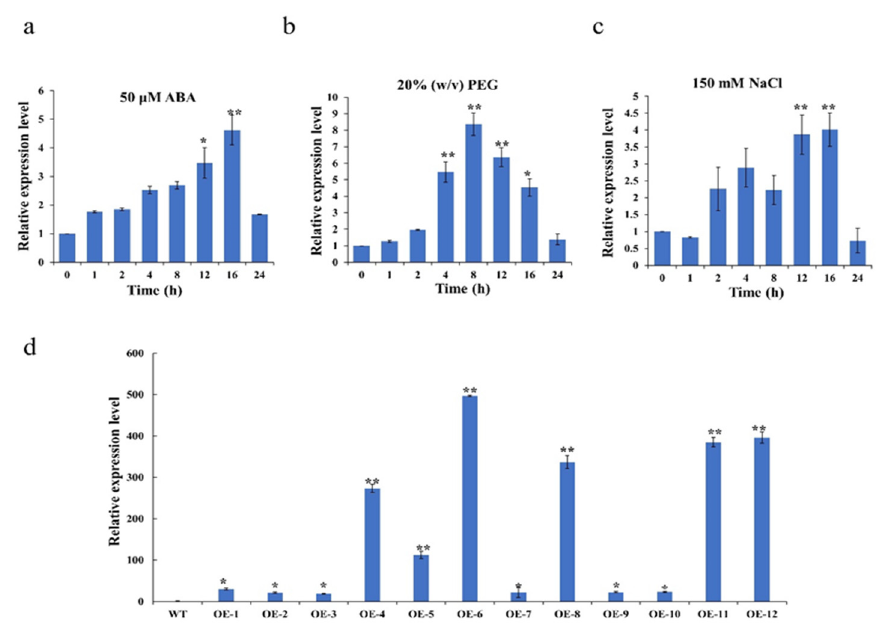
Figure 3. Expression analysis of OsMLP423 under different stresses and strains selection. ( a – c ) RT- analysis of OsMLP423 : ( a ) 50 µ M ABA; ( b ) 20% w / v PEG; ( c ) 150 mM NaCl. ( d ) Expression levels of PCR analysis of OsMLP423 : ( a ) 50 μ M ABA; ( b ) 20% w / v PEG; ( c ) 150 mM NaCl). ( d ) Expression OsMLP423 transgenic lines. Values are mean ± SE ( n = 3). Asterisks indicate significant differences levels of OsMLP423 transgenic lines. Values are mean ± SE (n = 3). Asterisks indicate significant between transgenic lines and WT (* p < 0.05, ** p < 0.01). n = 20 plants per differences between transgenic lines and WT (* p < 0.05, ** p < 0.01). n = 20 plants per treatment.